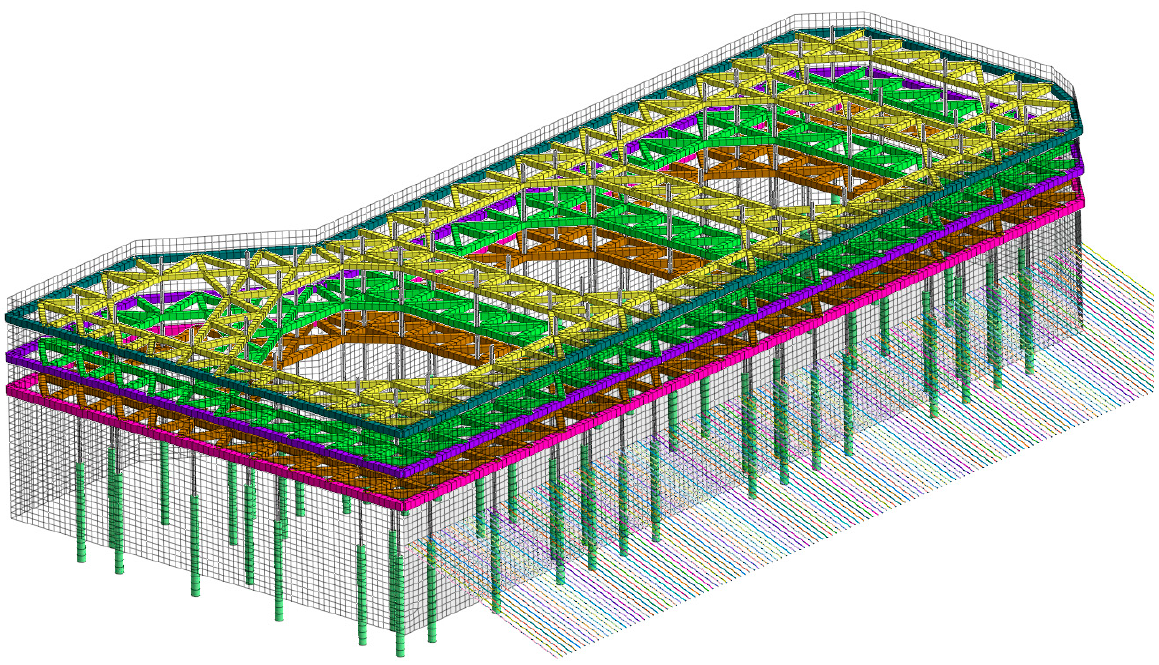
Figure 20. Schematic diagram of the structure simulation of the foundation pit support system.